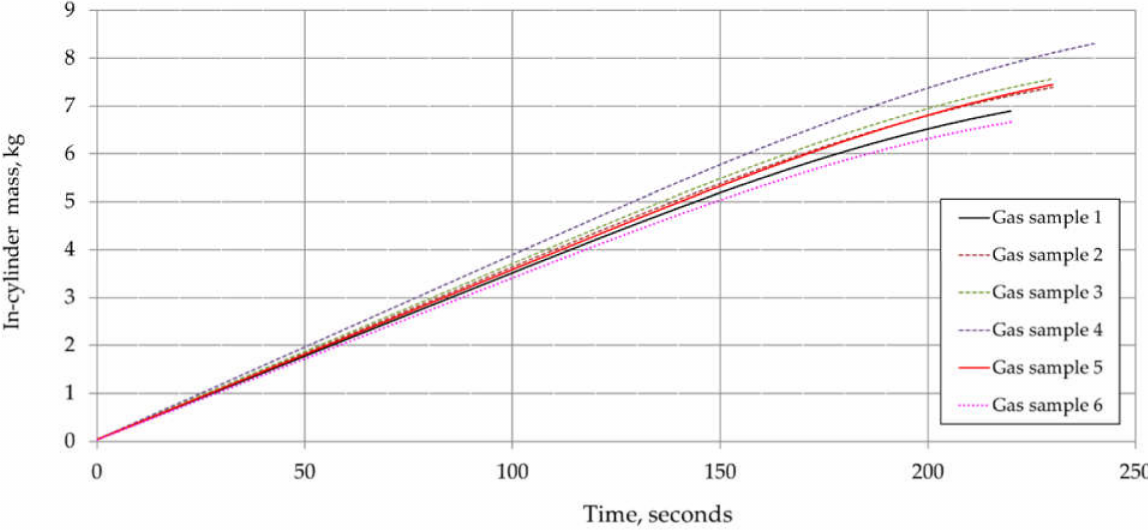
Figure 7. In-cylinder mass increase for the considered natural gas mixtures during the fast filling process of the composite tank (type IV).